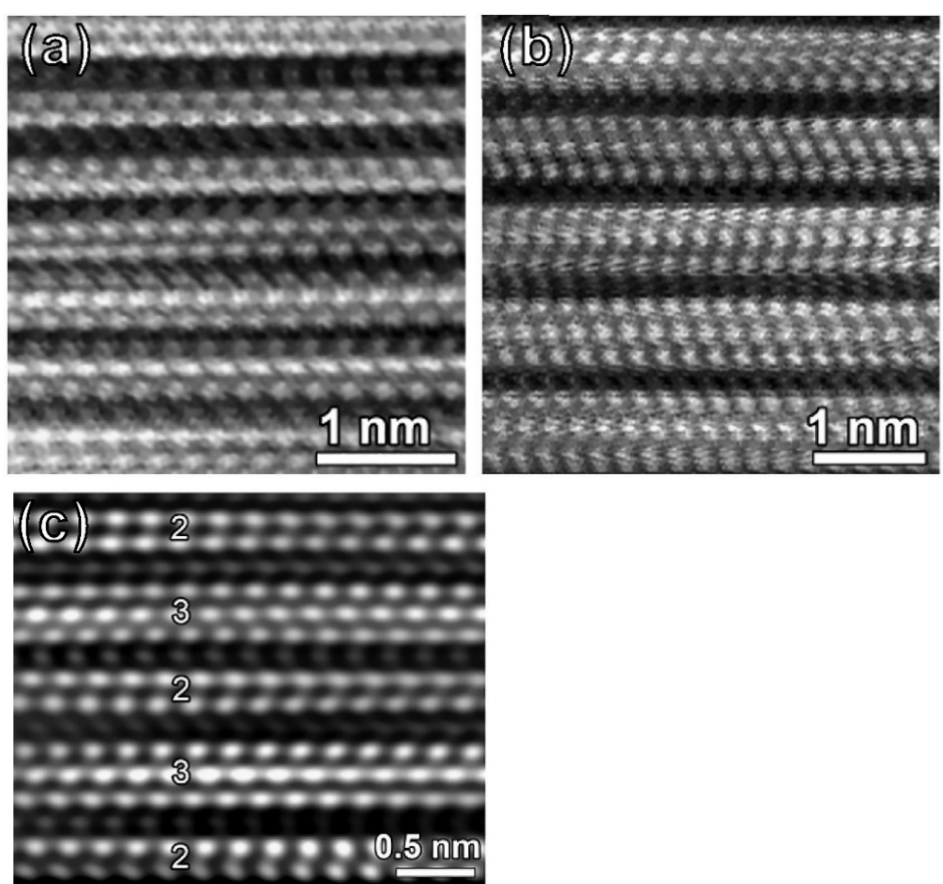
Figure 3. High-resolution Z contrast images of (V 0.5 Cr 0.5 ) 2 AlC ( a ); (V 0.5 Cr 0.5 ) 4 AlC 3 ( b ) and (V 0.5 Cr 0.5 ) 5 Al 2 C 3 ( c ) in the direction [1210]. Reprinted with permission from [30] 2008 John Wiley and Sons.